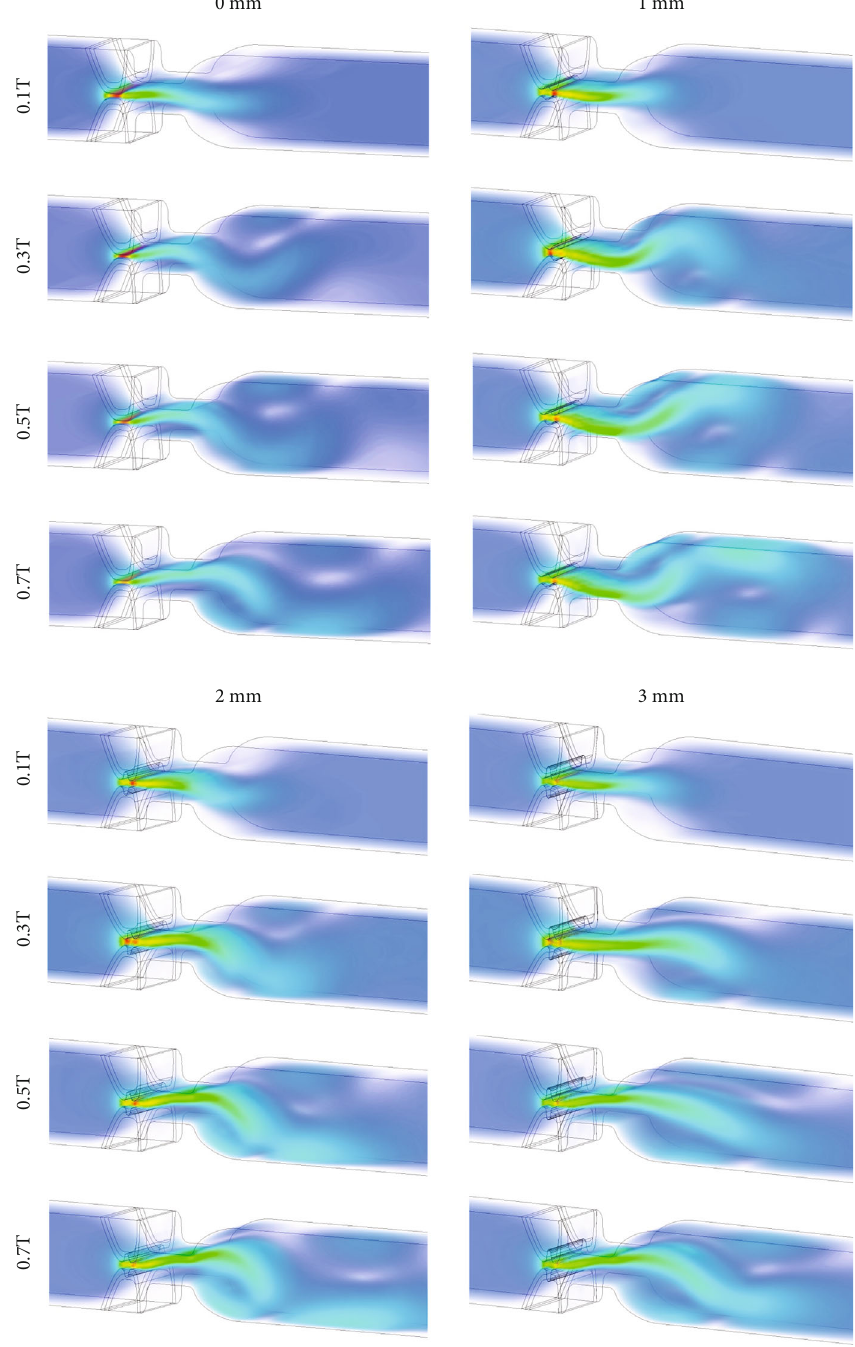
Figure 5: Contours of velocity at four di ff erent time instants in one cycle for healthy vocal fold (0 mm) and sulcus vocalis with di ff erent depths (1 mm, 2 mm, and